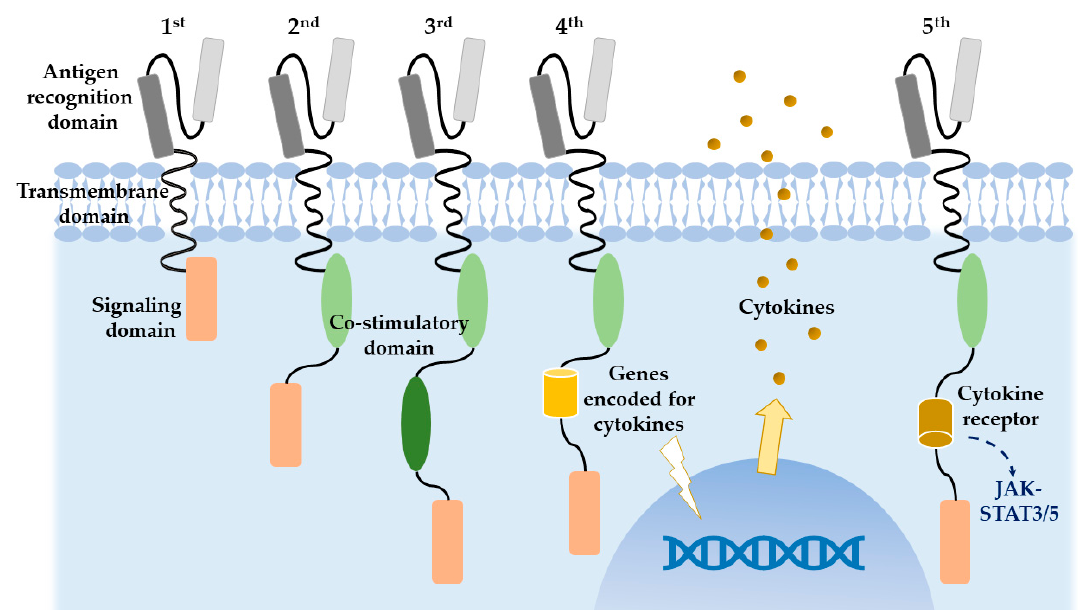
Figure 1. Structures of five generations of CAR T-cell therapy. The extracellular antigen-binding domain typically comprised of variable heavy and light chains to form a single chain variable fragment (scFv) from a monoclonal antibody. The ectodomain is then coupled with the endo-domain through the transmembrane domain. In the first generation, the intracellular domain is typically equipped with CD3 ζ of the T-cell receptor. In the second generation, CD28 or 4-1BB is added to the intracellular domain. The modified third generation then contains both. The novel fourth generation contains genes encoded for cytokines for transgenic expression, such as IL-12 and IL18, which can further activate cytokines. The developing fifth generation comprise of IL-2 receptor β -chain domain that further promotes cytokine cassette.